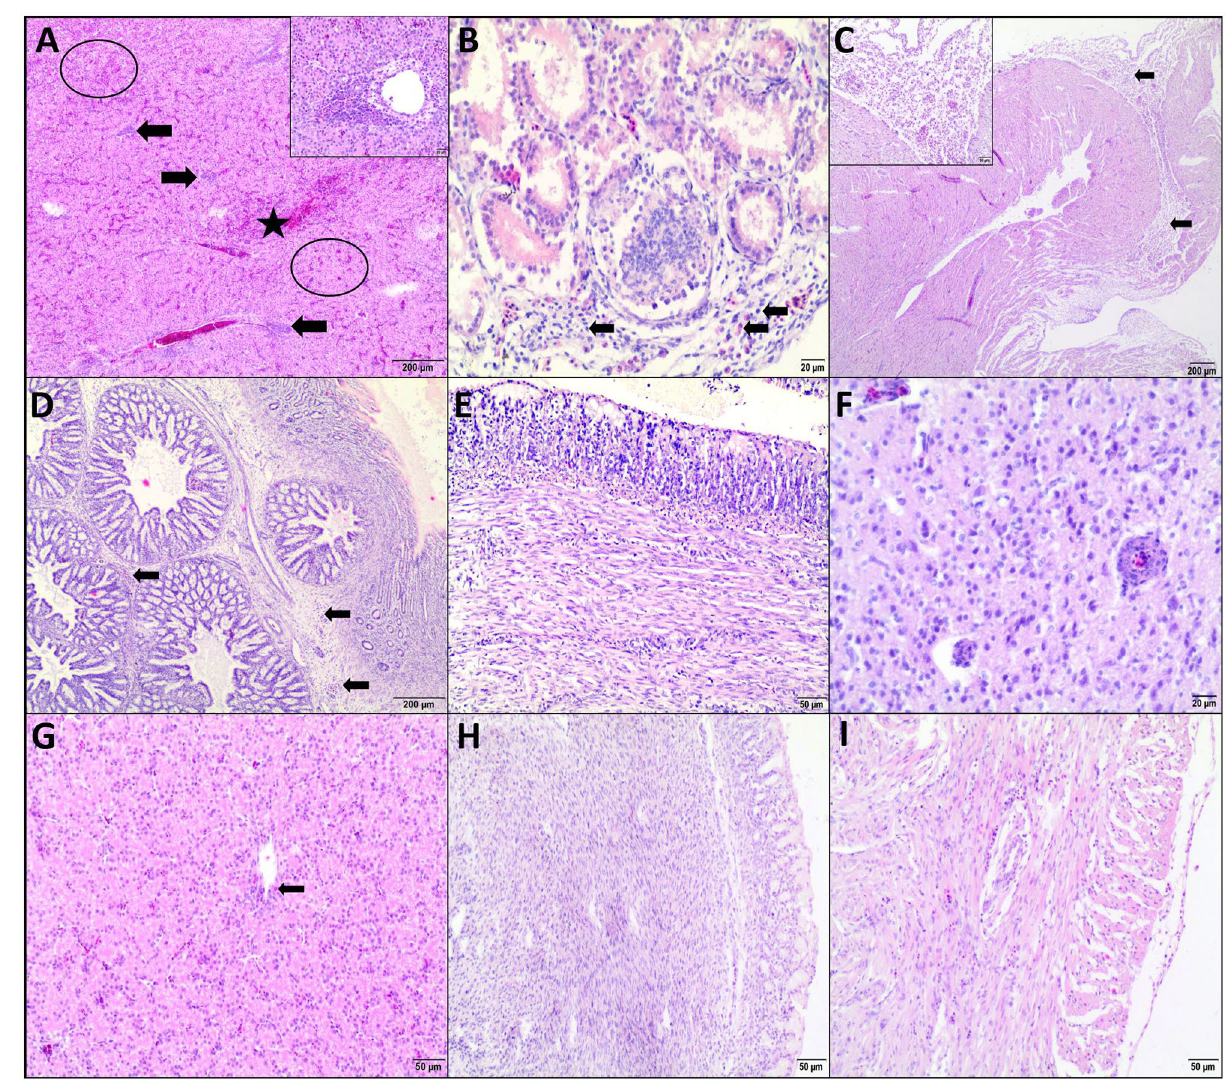
Figure 5. Histopathological lesions in chicken embryos that survived (7 dpi, 18 di) infection with clinical (A–F) and commensal (G–H) Enterococcus cecorum isolates and in non-infected embryos of the control group (I). (A) Liver: multifocal areas infiltration of heterophils and mononuclear cells (arrows), necrotic areas (circle), moderate congestion (*). Bar: 200 µm. Insert: moderate degree of inflammatory infiltrate, mild vacuolization of hepatocytes and increased number of bile pigment-laden macrophages. Bar: 20 µm. (B) Kidneys: diffuse markedly enlarged glomeruli, vacuolization and necrosis of epithelial cells. Arrows indicated inflammatory cells (heterophils and lymphocytes). Bar: 20 µm. (C) Heart: diffuse infiltration of pericardium and epicardium with heterophils and mononuclear cells. Bar: 200 µm. Insert: Bar: 50 µm. (D) Proventriculus: mild infiltration of inflammatory cells (heterophils and mononuclear cells) in the tunica intima and between deep glands, edema of the stroma. Bar: 200 µm. (E) Gizzard: there was no evidence of inflammation. Bar: 50 µm. (F) Brain: severe gliosis, capillary hyperplasia and endothelial hypertrophy, moderate neuropil vacuolization. Bar: 20 µm. (G) Liver: mild vacuolization of hepatocytes and infiltration of heterophils and mononuclear cells (arrow) around blood vessels. Bar: 50 µm. (H) Gizzard. No presence of inflammation. Bar: 50 µm. (I) Heart: no presence of inflammation. Bar: 50 commensal strains (22.29 g; 95% CI: 21.85 g, 22.72 g) (Supplementary Table 6). Group of strains (CB, BB, CL, T, W, commensal) had a significant impact ( p = 0.027) on the body mass of surviving embryos. Body mass was sig- nificantly lower in embryos infected with clinical strains from CB (21.44 g; 95% CI: 20.93 g, 21.95 g; p = 0.013), T (21.54 g; 95% CI: 21.08 g, 22.01 g; p = 0.022) , and W (21.33 g; 95% CI: 20.87 g, 21.78 g; p = 0.003) compared with those infected with commensal strains (22.29 g; 95% CI: 21.85 g, 22.72 g) (Fig. 6).